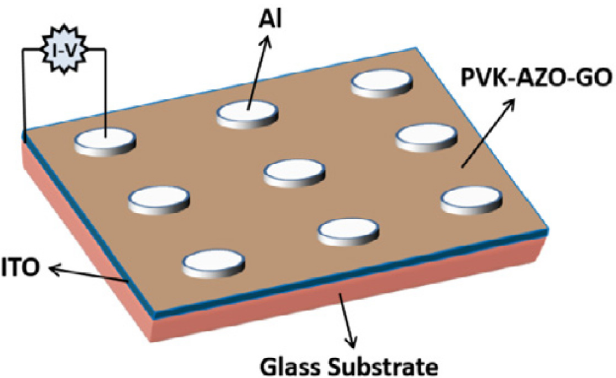
Figure 32. Structure of the Al/PVK-AZO-GO/ITO device (Reprinted with permission from [107]; Copyright @ 2018 Elsevier).